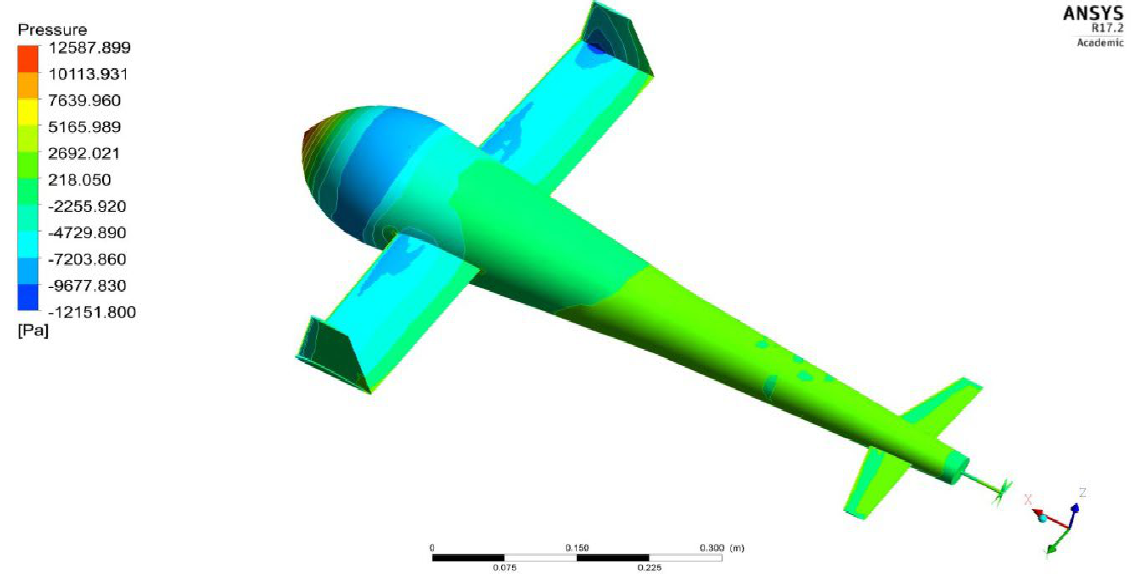
Figure 35. Hydrodynamic Pressure variations of optimised UAV.